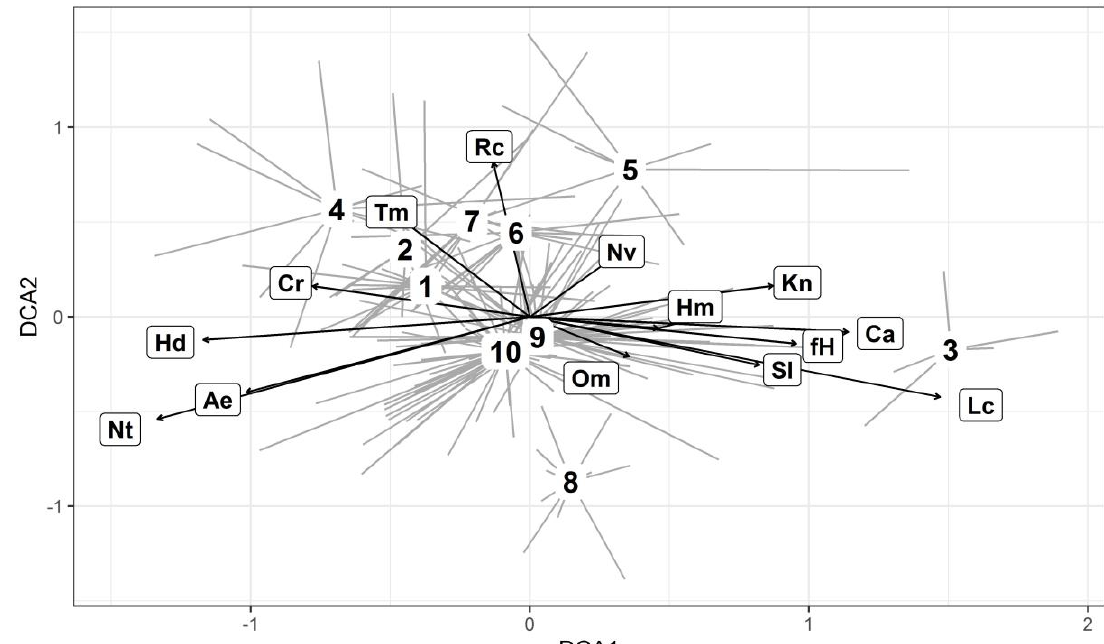
Fig. 5. Ordination analysis (DCA ordination) of the vegetation of afforestation belts syntaxa and projection of axes of ecological factors into the ordinance plane of the first two axes of ordination. Syntaxa numbers and designations of ecological factors are the same as in Table.